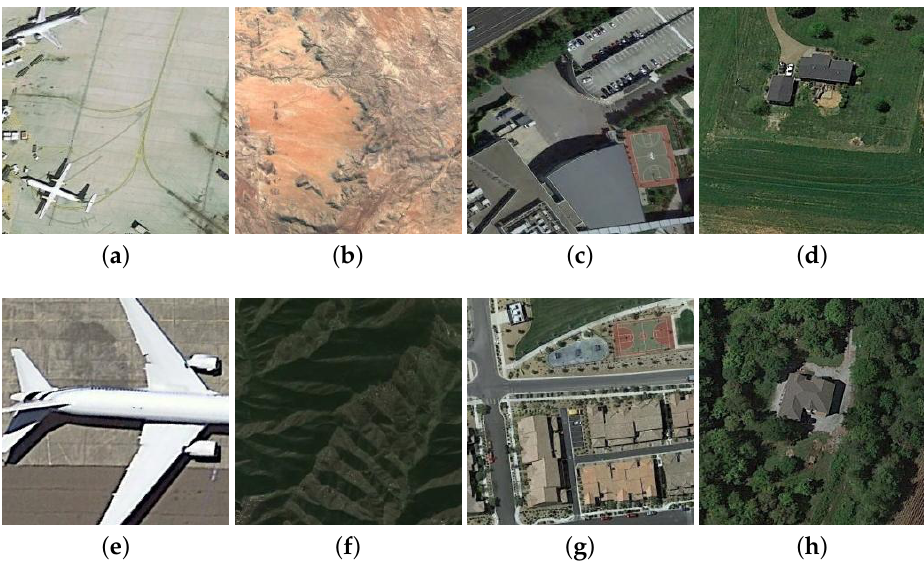
Figure 1. Some challenging cases in RSSC. For each column of image pair, they belong to the same class of scene, but ( a , e ) have high scale variability between objects, ( b , f ) have absolutely different appearance, ( c , g ) have a large number of noisy areas that interfere the discriminative regions, and ( d , h ) large redundant